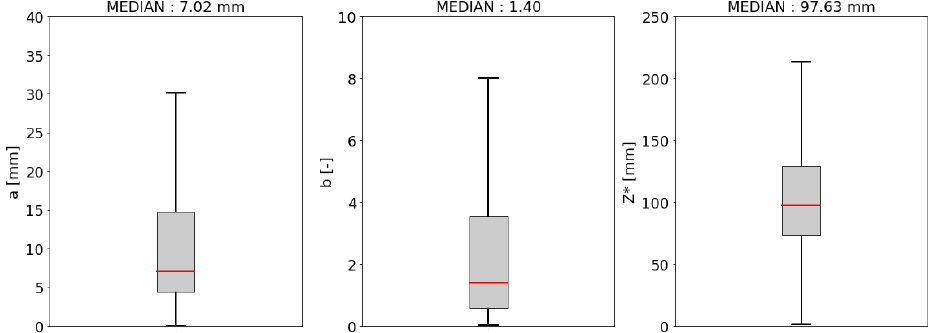
Figure A4. Boxplot showing the calibrated values of the parameters a , b , and Z ∗ over the Po valley.